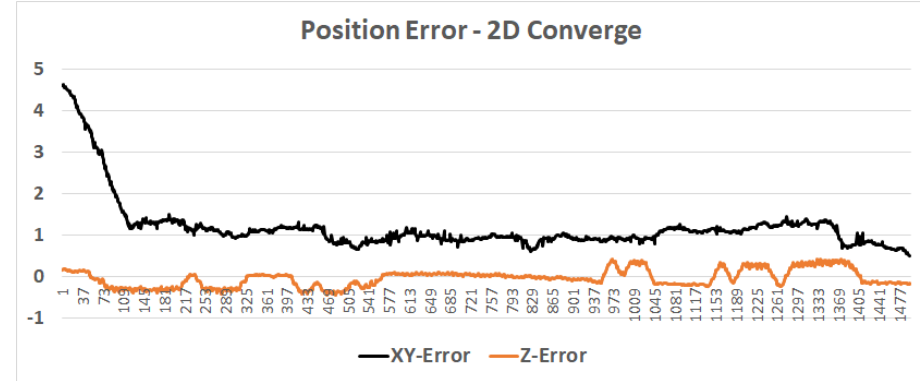
Figure 15. Particle filter 2 D convergence: Assuming the correct floor is known, the horizontal position convergence moves from an error of 4.5 m to about 1.3 m within 10 s (about 15 steps). During the rest of the test, the horizontal error is about 1 m, whereas the vertical error averages less than 0.5